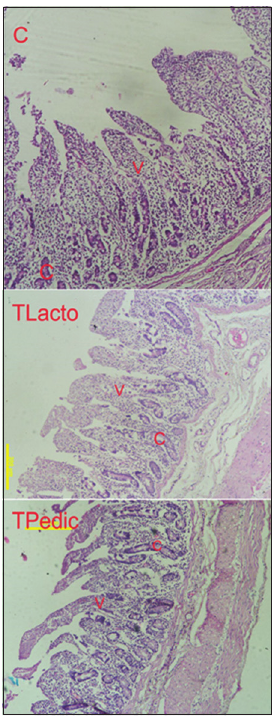
Figure-1: Change in intestinal morphology of grower pigs by feeding probiotics (hematoxylin/eosin stain 100×). The duodenum structure is regularly organized in villi (V) and crypt